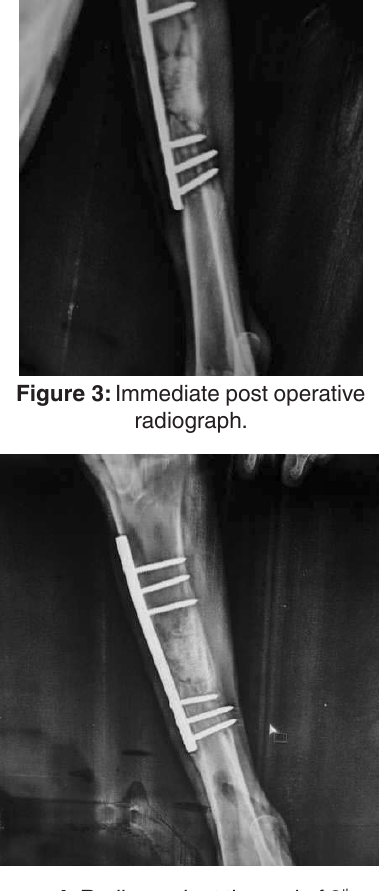
Figure 4: Radiograph at the end of 8 th post